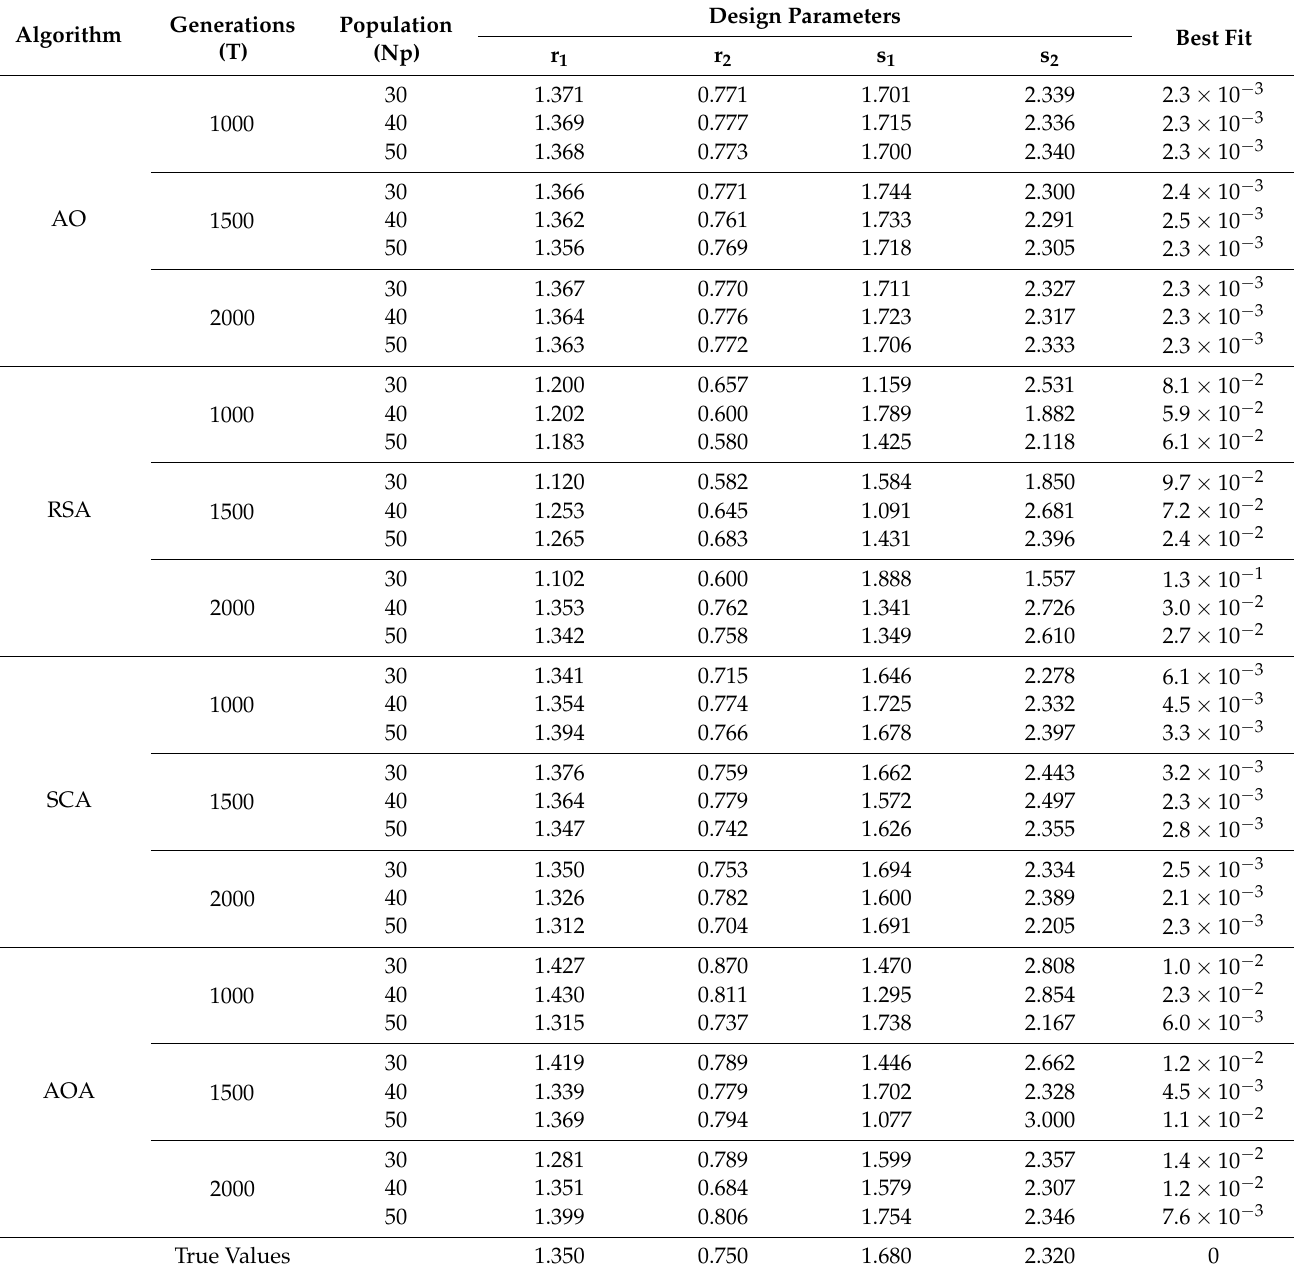
Table 16. Comparison of AO with AOA, SCA, and RSA against the true values for the CAR model at 0.06 noise